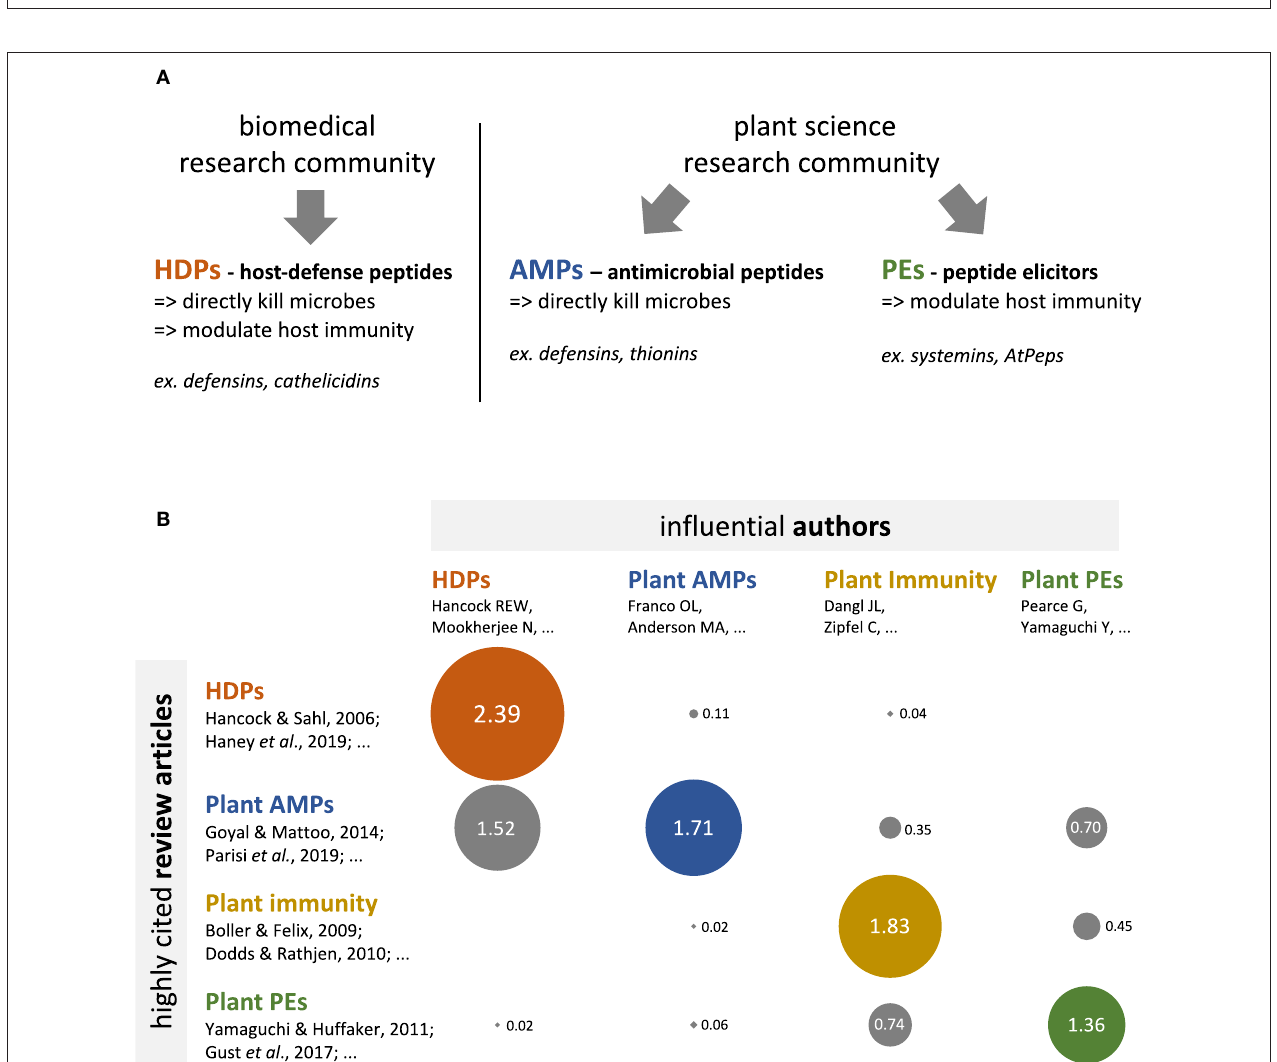
FIGURE 1 | Biomedical and plant science fields have different conceptual frameworks regarding defense peptides, and limitedly cite each other’s. (A) Conceptual frameworks pertaining to defense peptides in the biomedical and plant science research communities. The biomedical literature (left hand side panel) conceptualizes defense peptides as multifunctional molecules, with both antimicrobial and immunomodulatory activities, which are referred to as Host-Defense Peptides (HDPs). The plant science literature (right hand side panel) conceptualizes defense peptides as specialized molecules, which display either antimicrobial activities (antimicrobial peptides or AMPs) or immunomodulatory activities (peptide elicitors or PEs). (B) Bubble table chart depicting the results of a bibliometric analysis regarding the cross-referencing between HDP (red), plant AMP (blue), plant immunity (yellow), and plant PE (green) research communities. Numbers indicate the citation score for each field intersection (e.g., HDP vs. plant AMPs); that is expression of the average number of citations per author per article for a given field intersection (see Supplementary Methods for details). The diameter of the bubbles directly correlates with the indicated values. The analysis reveals that research communities are strongly compartmentalized, though some articles and ’transversal’ authors evolve at the interface of the various research communities (see Supplementary Table 1 for details).